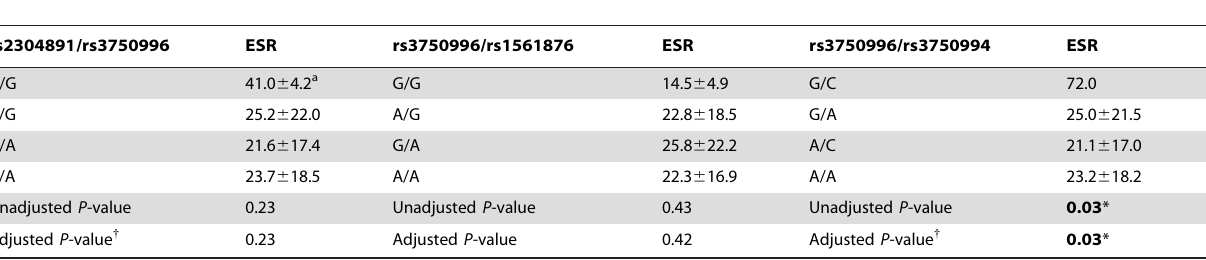
Table 4. Difference in the value of ESR among HLA-B27 positive AS patients stratified by different STIM1 haplotypes.